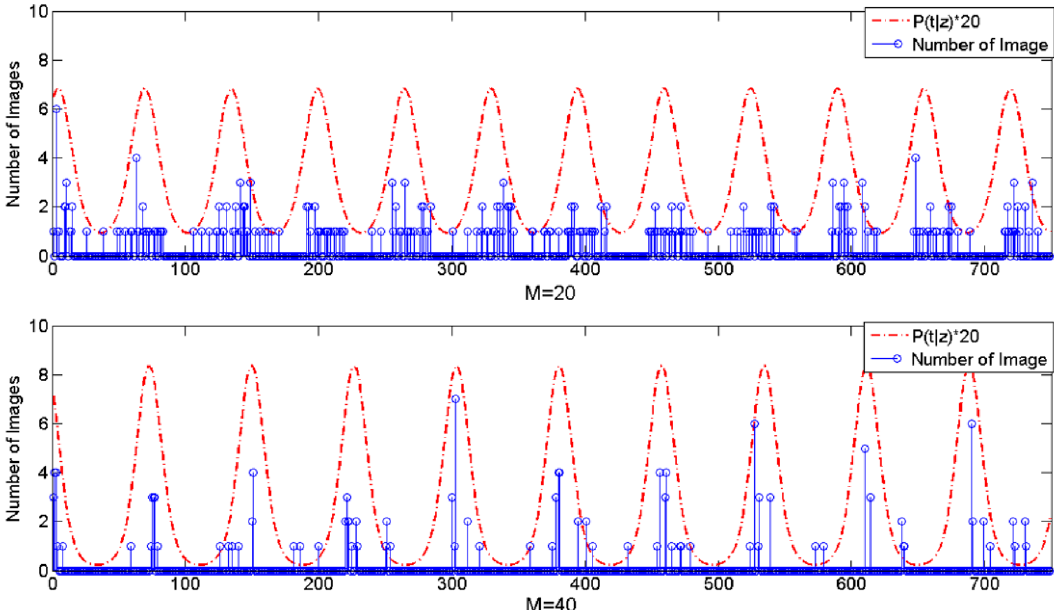
Figure 13. The probability distributions of tasks over time.